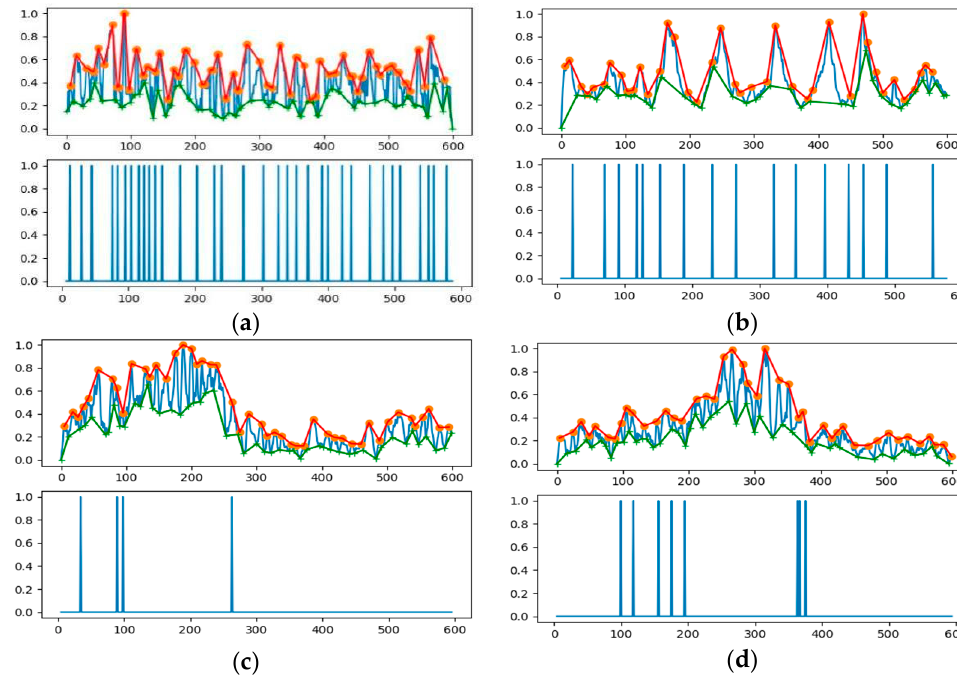
Figure 17. Zero-crossing spectrum. ( a ) Without sand wave. ( b – d ) With sand waves.